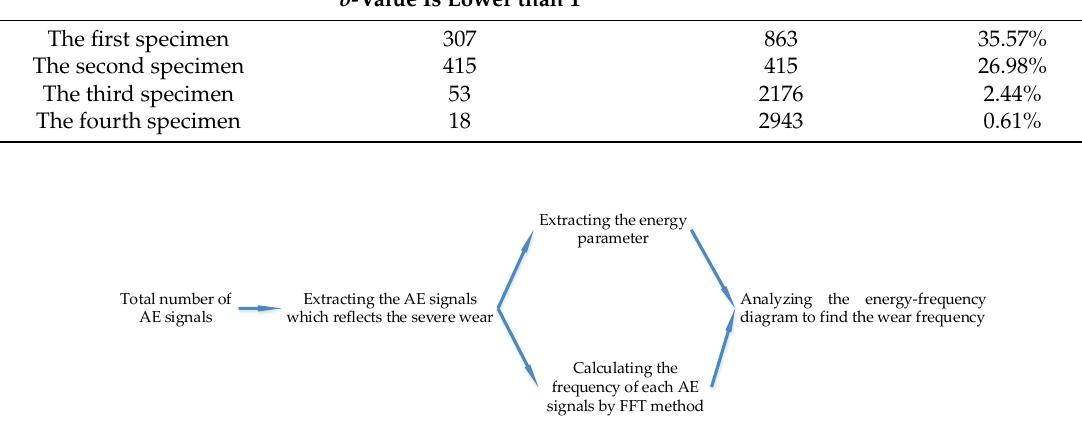
Figure 9. The flow chart of frequency-based analysis.